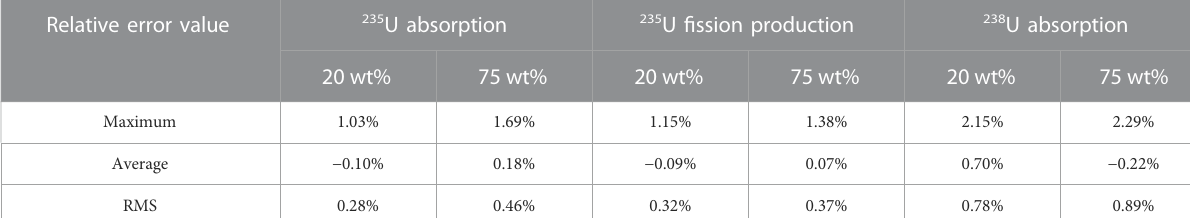
TABLE 8 Calculation results of the resonance cross section for 20 and 75wt% cases.